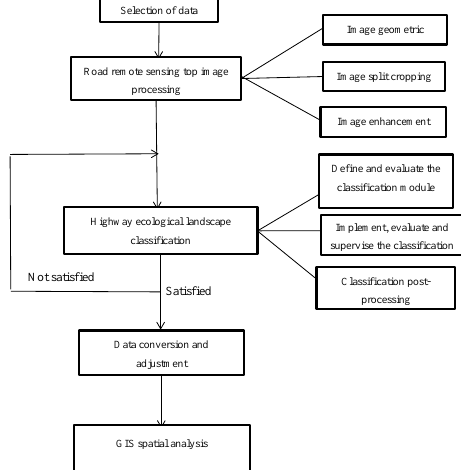
Figure 2: Research flow of ecological identification of highway road